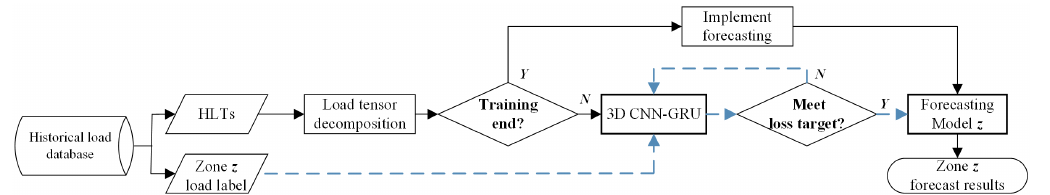
Figure 1. Flowchart of the proposed scheme. The “zone z ” is one of the zones covered by the historical load matrix